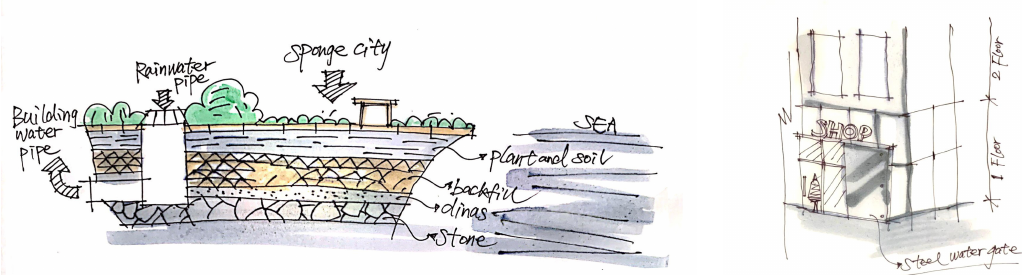
Fig. 8 A sketch of the design concept of buffer